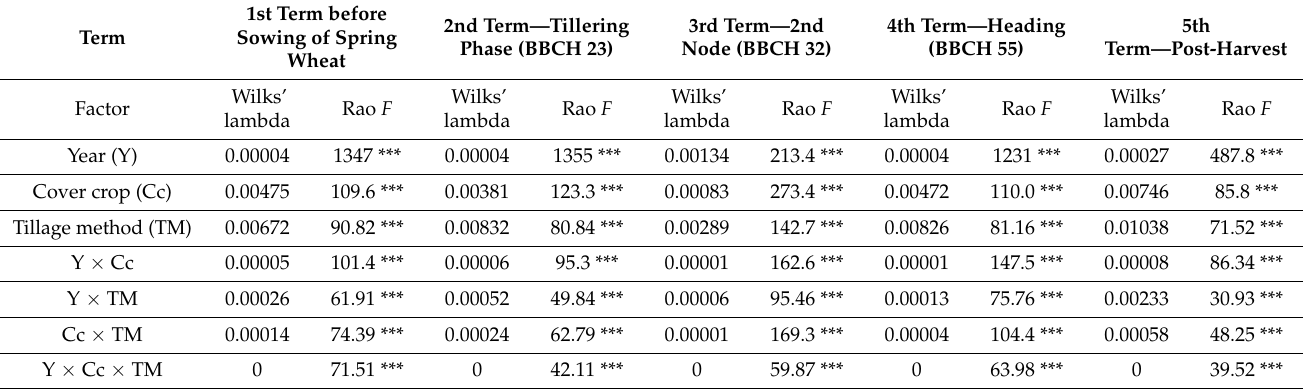
Table 2. Results of multivariate analysis of variance (MANOVA) for field experiment conducted at Brody Research and Education Station, Pozna´n University of Life Sciences, Poland (52 ◦ 26 (cid:48) N; 16 ◦ 17 (cid:48) E) in 2011–2013. *** p < 0.001.